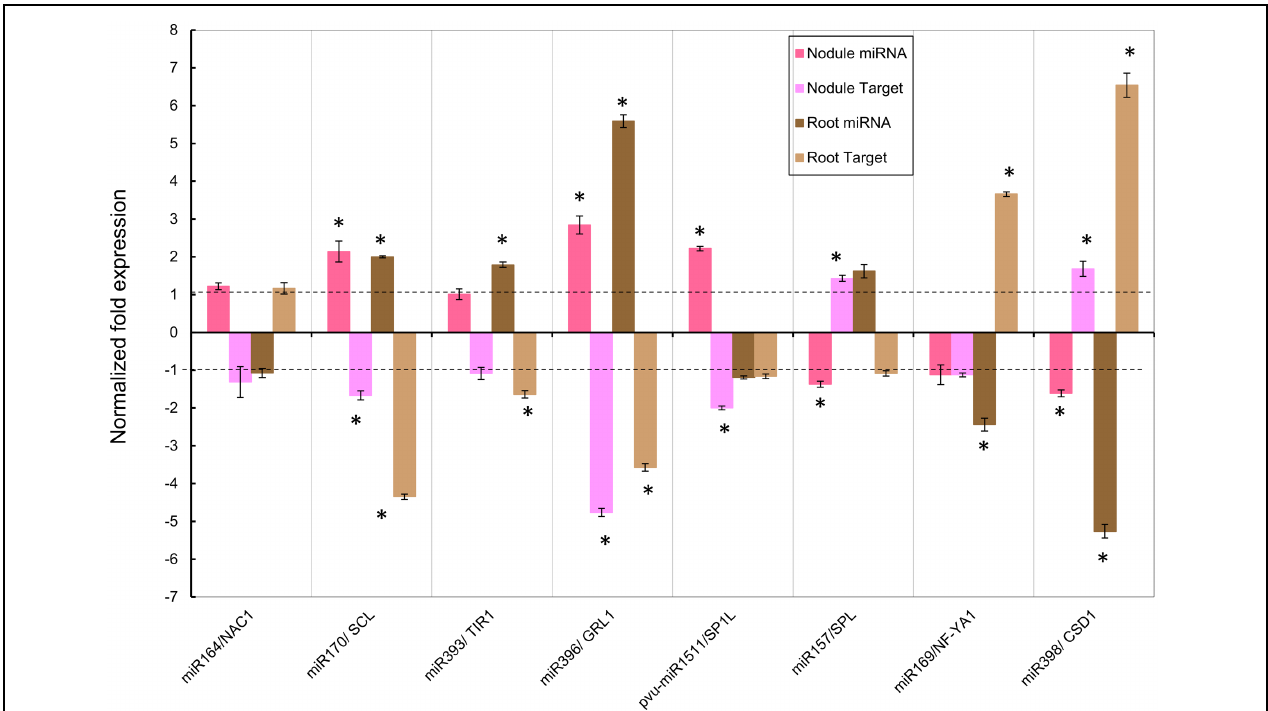
FIGURE 5 | Normalized fold expression levels of selected miRNAs/target mRNA nodes in fertilized roots and in SNF nodules of common bean plants under Alt for short period. High Al was added to (12 dpi) R. tropici -inoculated plants with active young nodules or to (12 days) fertilized plants for 24 h before harvesting. miRNAs and target genes expression levels were determined by qRT-PCR in nodules of inoculated